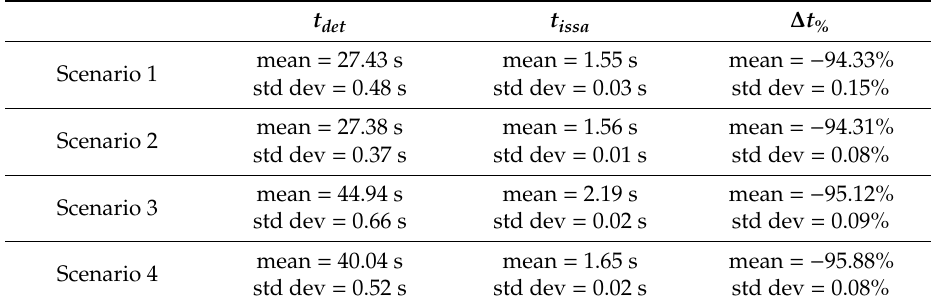
Table 7. Execution time performance evaluation, case B (simulation time step 2 · 10 − 5 s), Computer 2 *. t det t issa ∆ t % mean = 27.43 Scenario 1